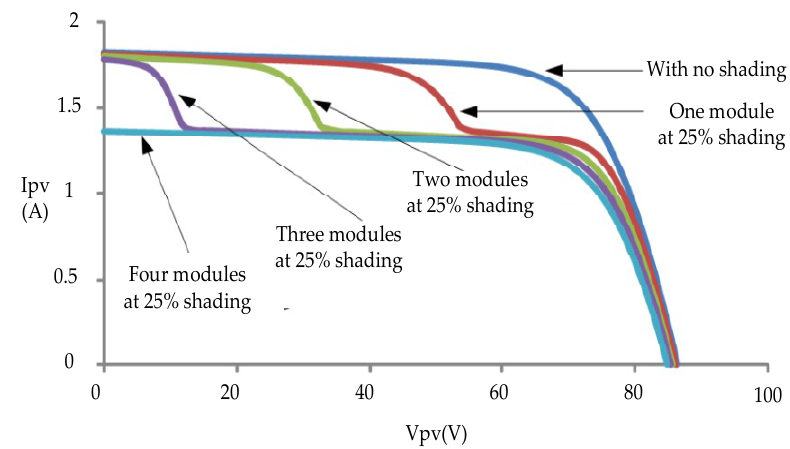
Figure 1. Simulated I–V characteristic curve when different modules in the four-series and one-parallel connected module array have 25% shading.